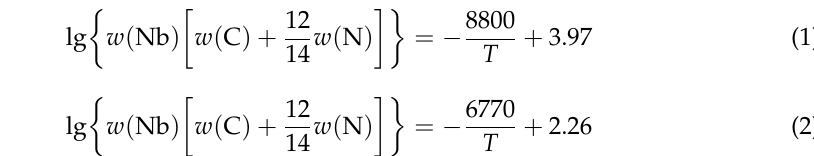
Figure 2. Prior austenite grains and undissolved phase at ( a , c ) 1100 °C and ( b , d ) 1200 °C.